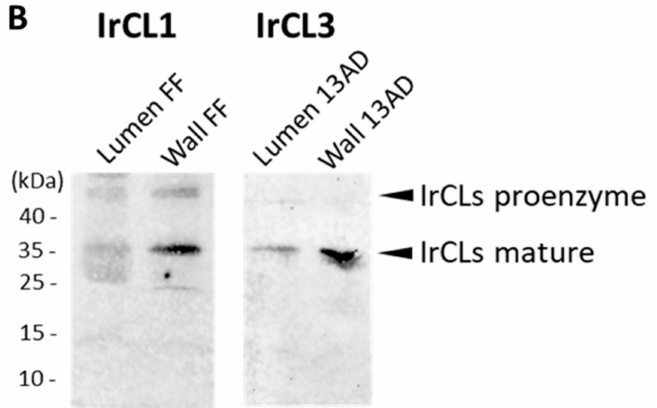
Figure 3. Western blot analysis of mialostatin, IrCL1, and IrCL3 in the tick midgut. ( A ) Tick midgut wall tissue extracts from various stages of tick feeding and midgut lumina from fully fed ticks were analyzed by SDS-PAGE and Western blotting. Mialostatin was labeled with a mouse monoclonal antibody and its signal detected using a fluorescently labeled secondary antibody. ( B ) Tick midgut wall and midgut lumen homogenates from fully fed ticks were analyzed by SDS- PAGE and immunoblotting with α -IrCL1 and α -IrCL3 rabbit polyclonal antibodies. Goat α -rabbit IgG Alexa 488 fluorescent secondary antibody was used to visualize protein bands using ChemiDoc MP imager. 6d—sixth day of feeding; FF—fully fed; 6, 7, 13, 15 AD—days post detachment from the host. Lum. serum—luminal fluid from ticks fed on erythrocyte-free serum; rMista—recombinant mialostatin. Full view of presented Western blots can be found in the Supplementary Materials, Figures S2–S4.